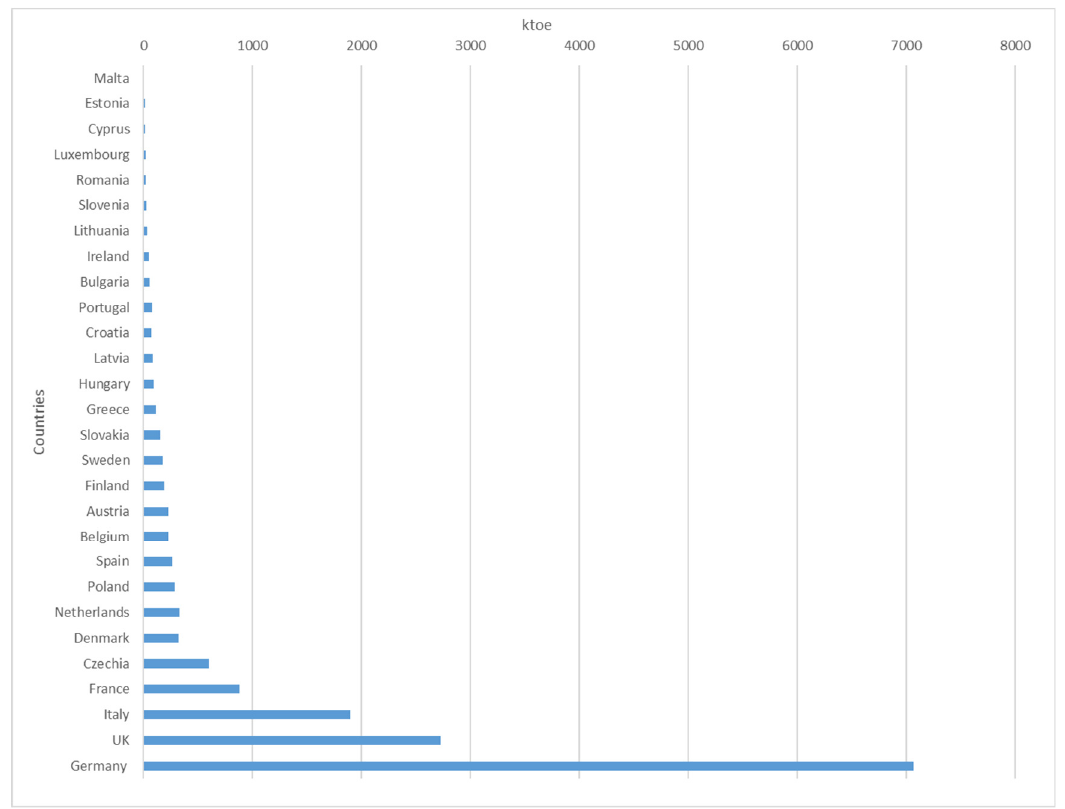
Figure 5. Biogas production in ktoe by countries (according to [135]).